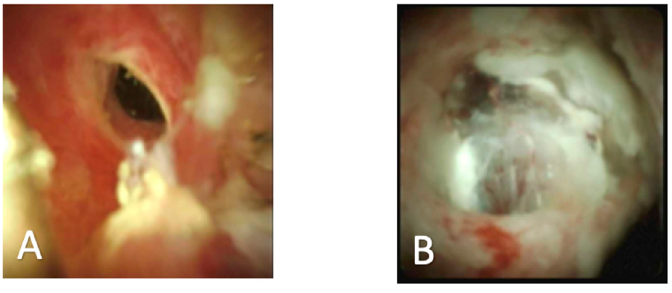
Figure 2. ( A ) Benign inflammatory bile duct stricture; ( B ) Stricture formation with malignant transformation.